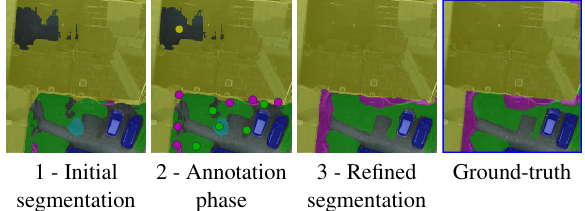
Figure 1. Example of the proposed interactive semantic segmentation approach on the ISPRS Postdam multi-class dataset (Rottensteiner et al.,